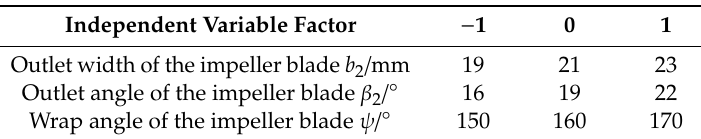
Figure 1. Definition of key parameters. Table 1. Factor settings.